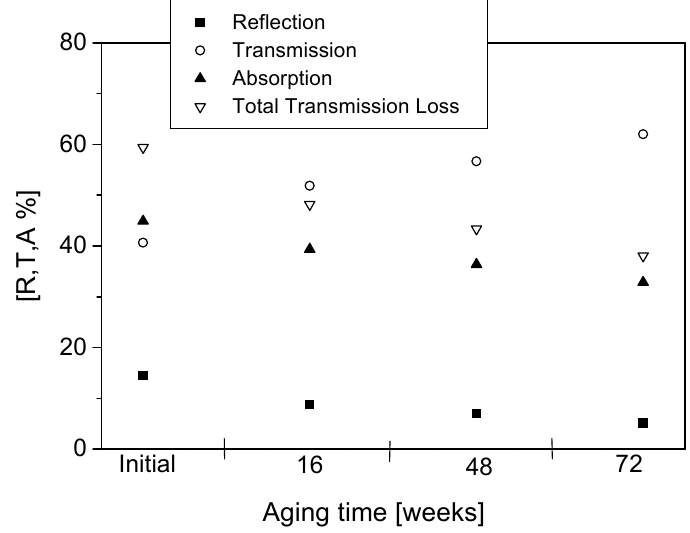
Figure 9. Reflection, transmission, absorption and total transmission loss for PPy- p TSA–coated Nylon-Lycra. Polymerisation time: 60 min, p TSA concentration: 0.015 mol/L. Please make the explanations smaller and put them inside the piture like the Figures 5–9.